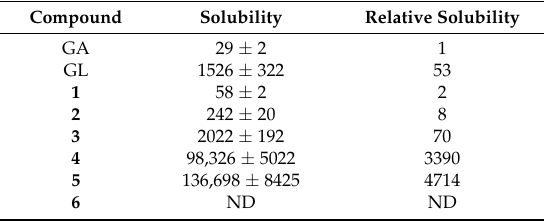
Table 2. Water solubility of GA, GL and the glycosylated products ( µ